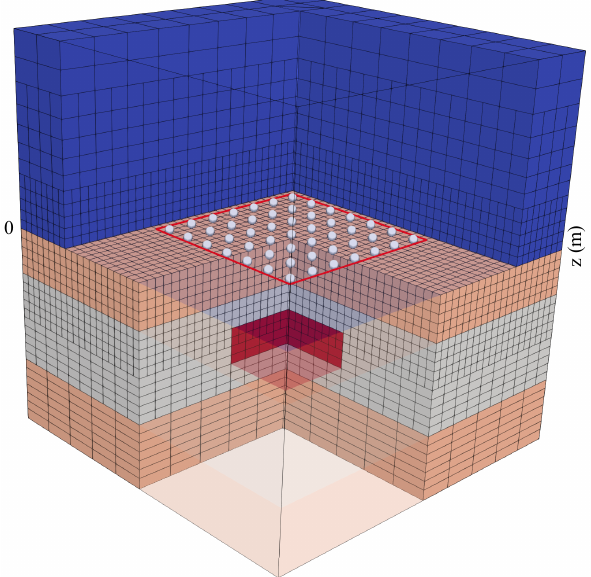
Figure 1. Sketches of the ground TEM survey configuration using the loop source and the dis- cretization of the multi-resolution grid. Red lines represent the loop source; white points represent measurement sites; the blue region indicates the air